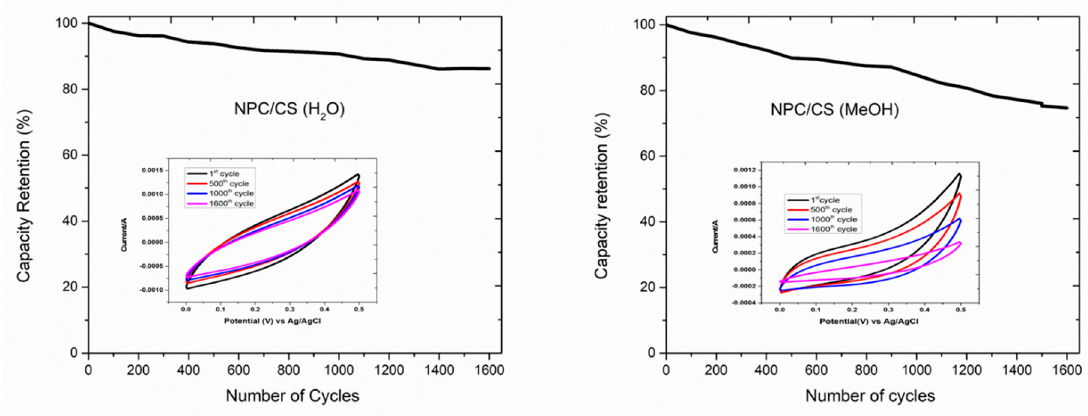
Figure 7. Numbers of cycles versus capacitive retention for the electrode NPC/CS electrode materials recorded over 1600 cycles at a scan rate of 100 mV/s.